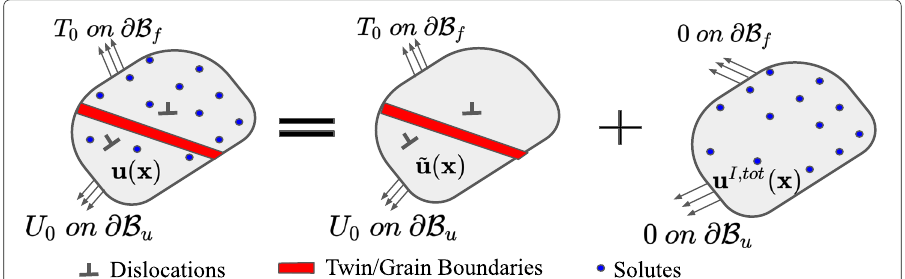
Fig. 1 Decomposition of the defected body with interstitial solutes problem into the problem of a defected body (the ˜ ( ) field) and the complementary problem of a body with solutes only (the () I , tot